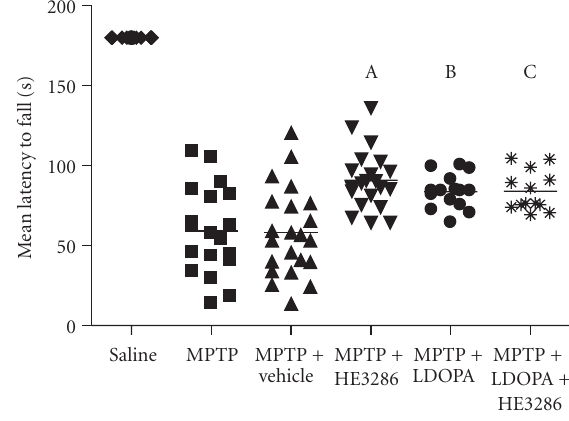
Figure 2: HE3286 e ff ect on motor impairment in experiments 1–3 combined. Mice (male, C57/Bl6 mice, 8 per group) were given four injections of 20 mg/kg MPTP 2h apart. L -DOPA (24.8 mg/kg i.p.) and L -DOPA (i.p.) in combination with HE3286 (40mg/kg gavage) were administered for 4d beginning 1 h prior to MPTP, or HE3286 (40mg/kg), vehicle or saline was administered by gavage twice daily for four consecutive days beginning 1h after the last MPTP injec- tion. Motor impairment was measured using the rotorod test (A, P < 0.0001 compared to vehicle, B, P = 0.0016, C, P =